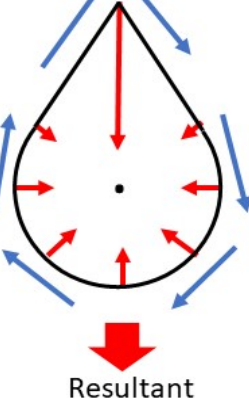
Figure 3. Qualitative distribution of the velocity (cid:126) V (blue arrows) and acceleration D (cid:126) V / Dt (red arrows) along the boundary section of the ring (compare with Figure 2). The section has been designed in order to enforce a sharp variation in (cid:126) V on top. This locally results in high values of D (cid:126) V / Dt (red arrow pointing down on top), which are not compensated by the integral extended to the remaining portion of the boundary. The final resultant turns out to be different from